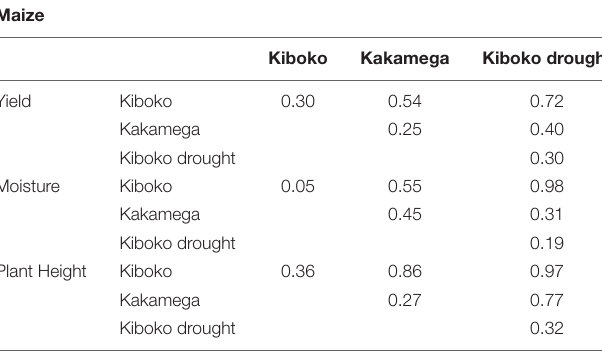
TABLE 2b | Plot level heritabilities and genetic correlations across three environments for